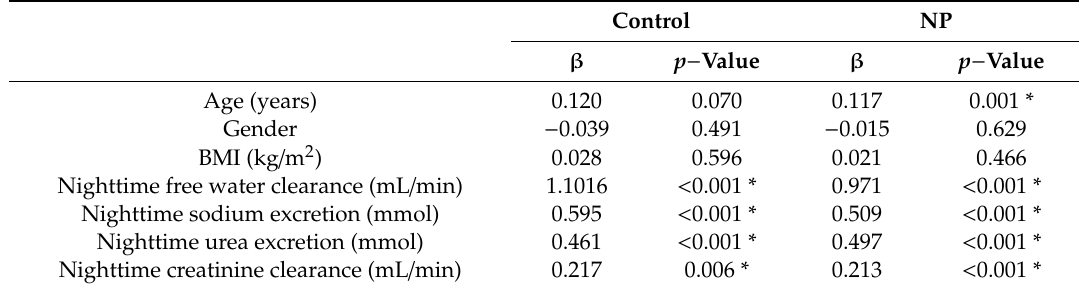
Table 2. Multiple regression analysis for risk factors associated with nighttime diuresis rate.